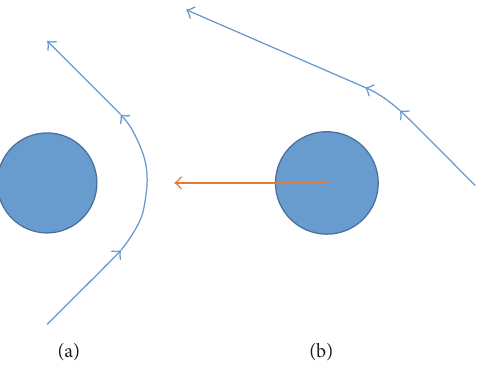
Figure 1: An example of a gravity assist maneuver as seen in a reference frame fixed to the planet (a) and fixed inertially